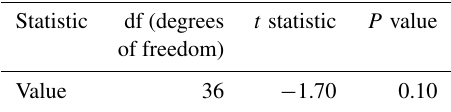
Table D1. Table displaying t -test results for the 2015–2016 drought period risk assessment versus literature results.